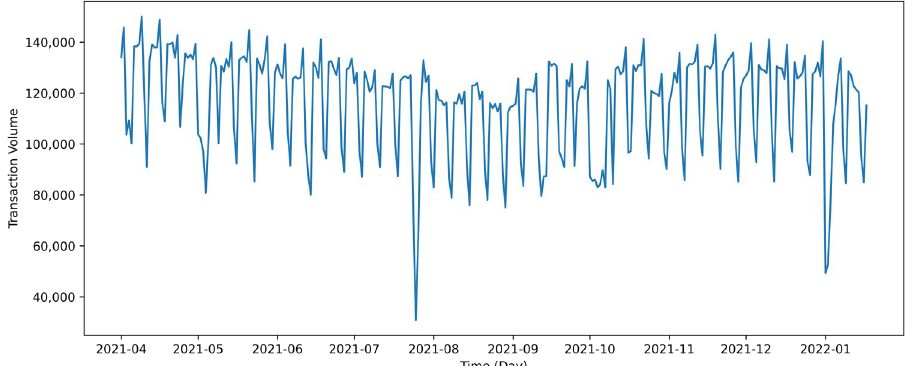
Figure 3. Total daily ridership during the 10-month study period.